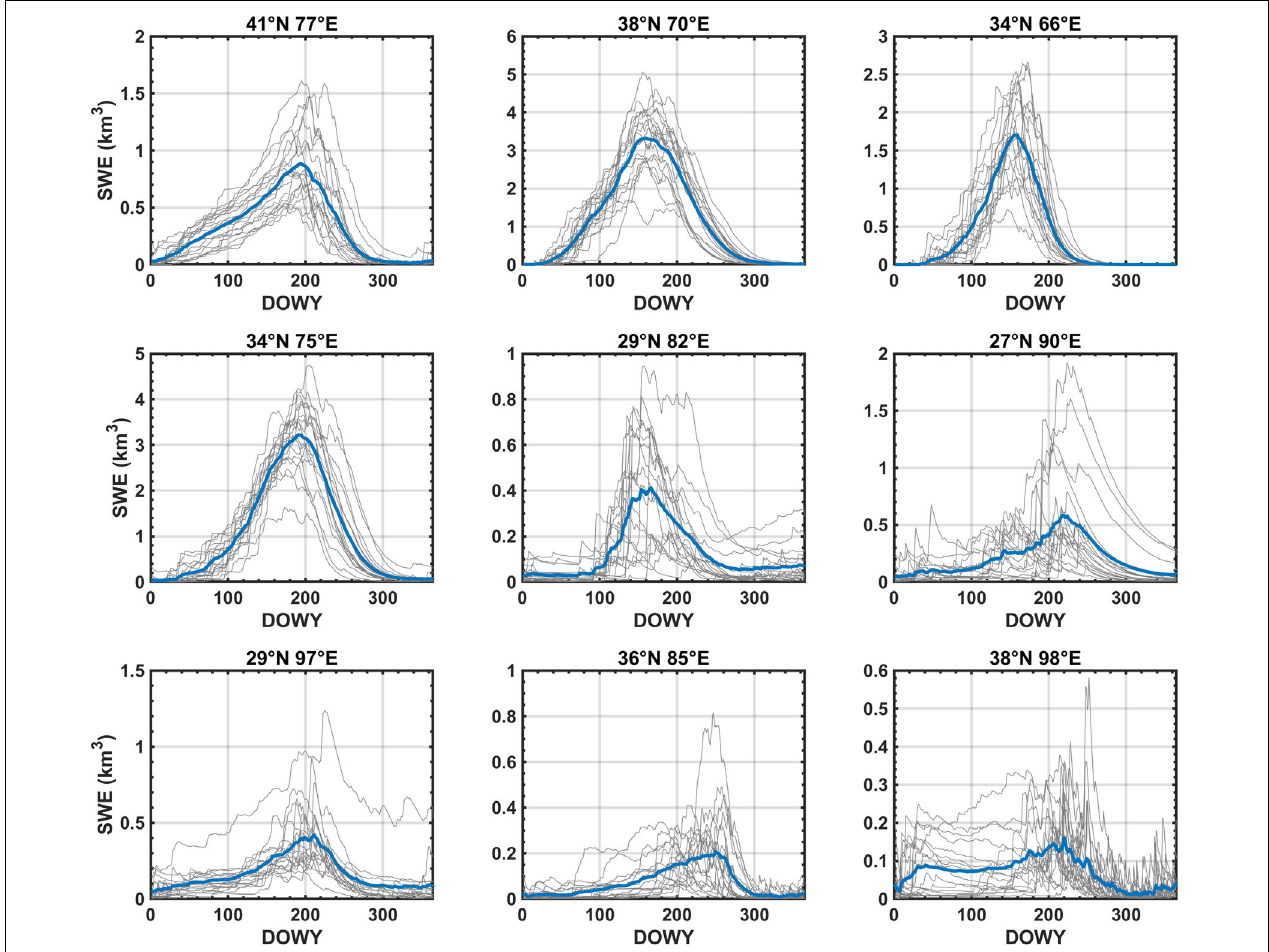
FIGURE 13 | Tile-averaged seasonal cycle in SWE volume (km 3 ) for HMA test tiles. The 18-year climatology is shown with the thick blue line. Individual years are shown with thin gray lines for